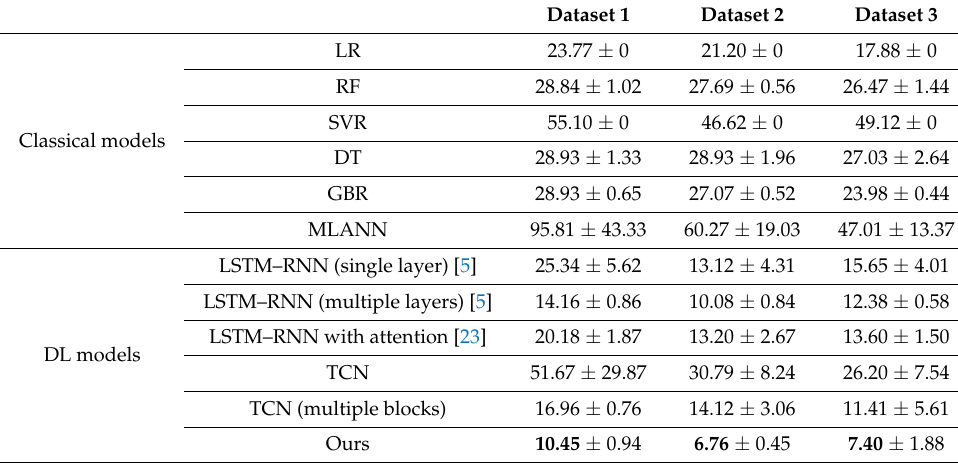
Table 6. Statistical metrics (mean and standard deviation) of RMSEs (g/m 2 ) obtained by different methodologies for three